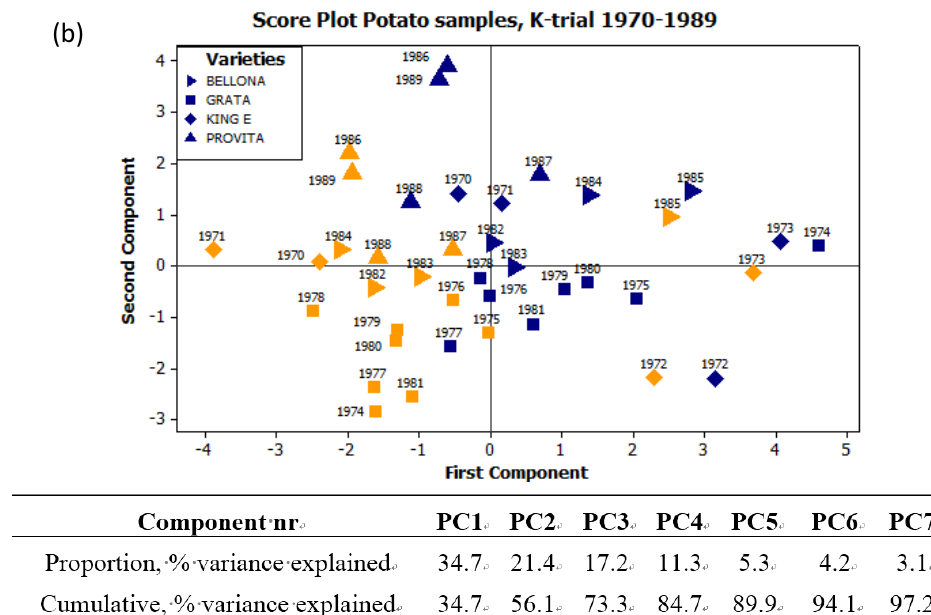
Figure 4. PCA plots on potato samples from the K-trial 1970–1989. ( a ) Loading plot of all common 11 analyses; ( b ) Score plot expressing manuring systems, cultivars and seasons. Cultivars: 1970–1973 King Edward, 1974–1981 Grata, 1982–1985 Bellona, 1986–1989 Provita. Orange symbols: biodynamic compost, blue symbols; conventional inorganic fertilizer.